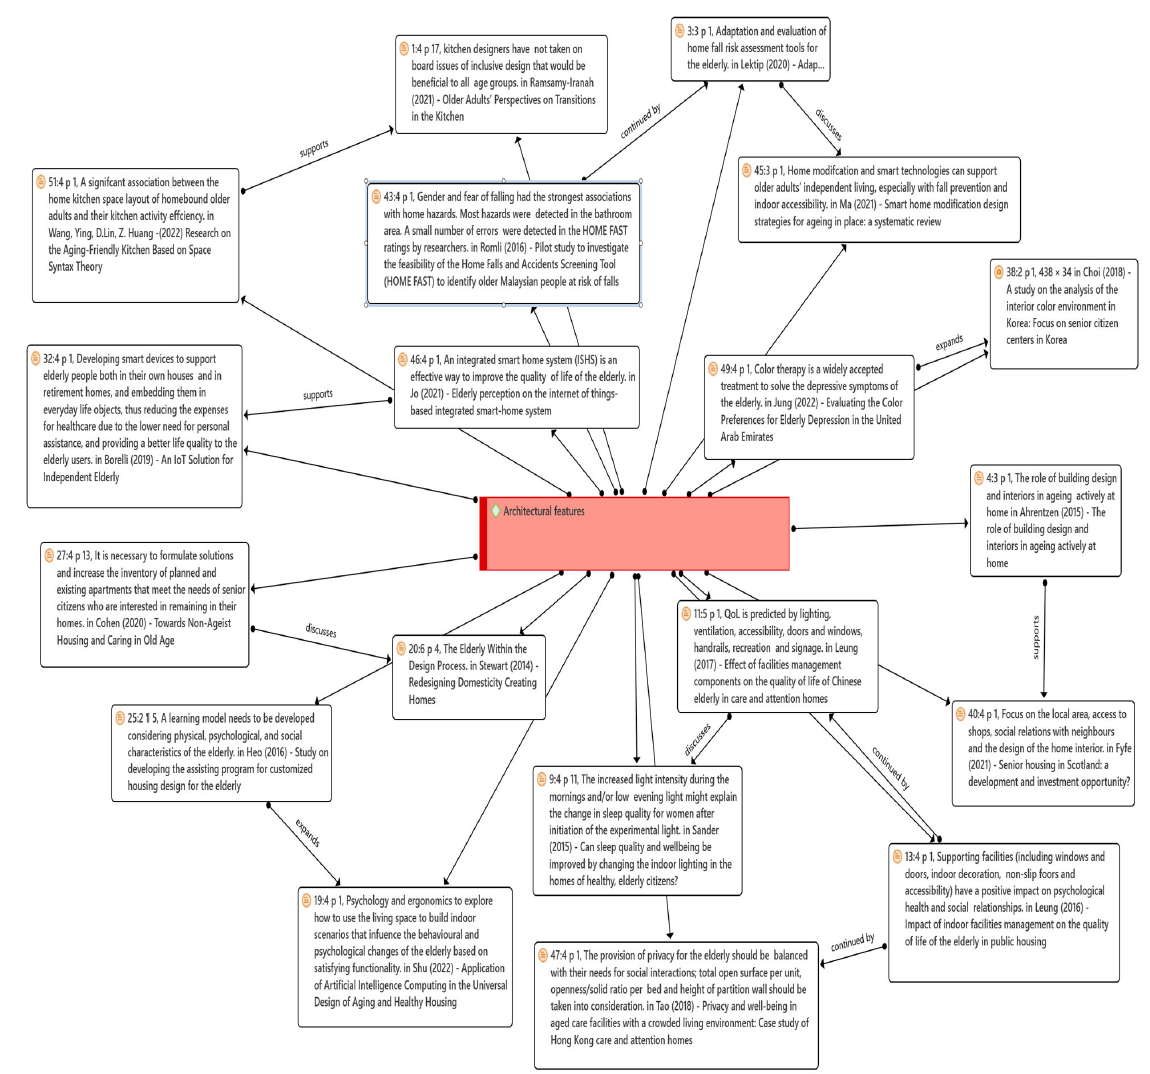
Figure 6. Architectural features